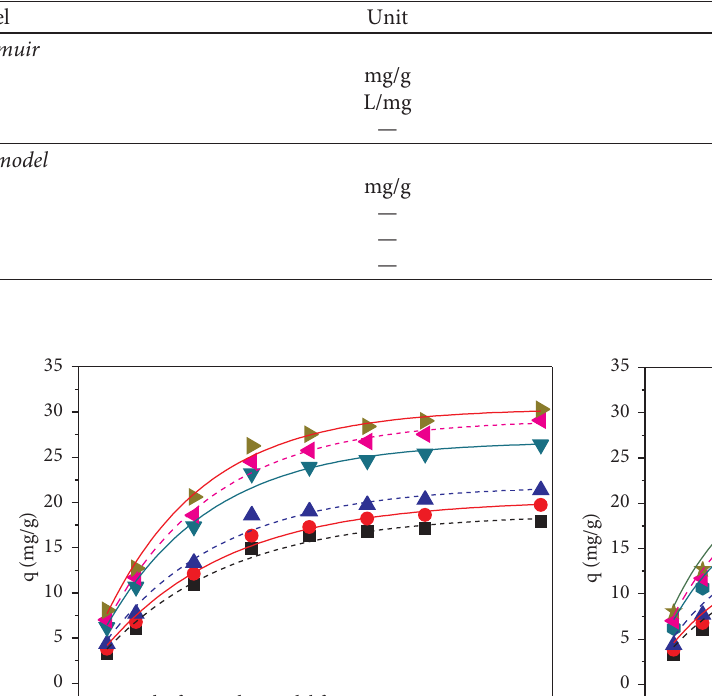
Figure 10: The adsorption isothermal equilibrium prediction of RR21 onto PPB and FO5-PPB at a contact time of 60min and adsorbent dose of 2g/L. Table 1: Adsorption isothermal parameters and correlation coefficients of Langmuir and Sips models for RR21 adsorption onto PPB and FO5-PPB at different temperatures.